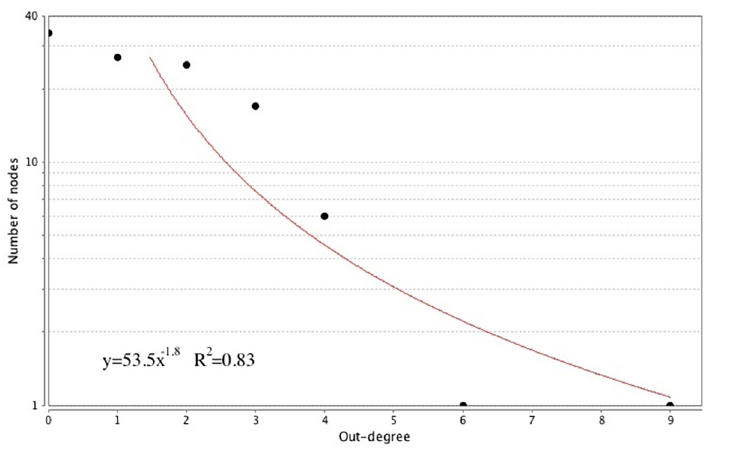
Fig 3. Out-degree Distribution of the CHIDS Network (logarithmic scale).